Question: Briefly state, in one sentence, what is plotted here.
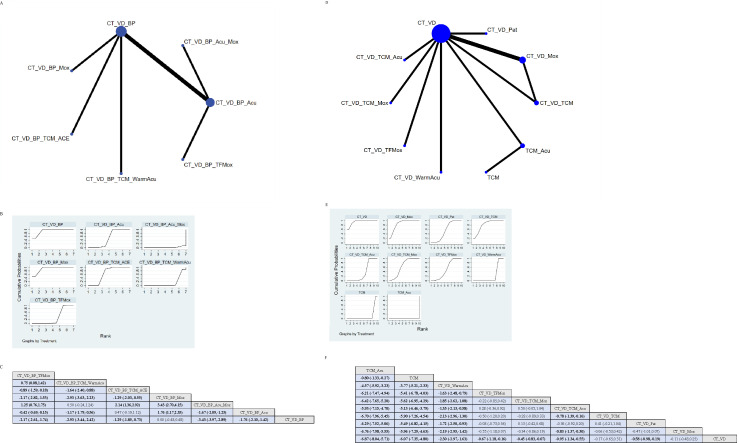
Answer: Network meta-analysis of low back pain score of TCM syndrome score. (A) Network plot of the network meta-analysis for low back pain score of TCM syndrome score (include BP). (B) Rankogram of overall intervention strategies from the network meta-analysis for low back pain score of TCM syndrome score (include BP). (C) League table of the network meta-analysis for low back pain score of TCM syndrome score (include BP). (D) Network plot of the network meta-analysis for low back pain score of TCM syndrome score (exclude BP). (E) Rankogram of overall intervention strategies from the network meta-analysis for low back pain score of TCM syndrome score (exclude BP). (F) League table of the network meta-analysis for low back pain score of TCM syndrome score (exclude BP).